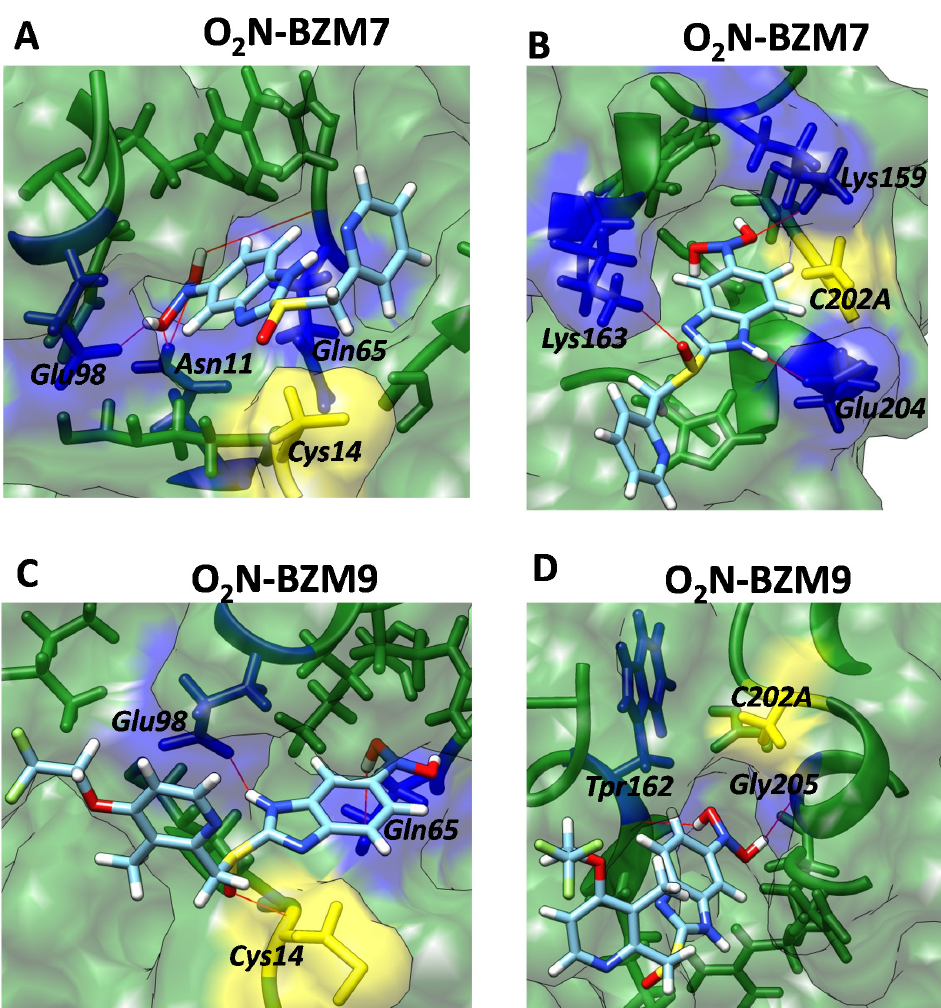
Figure 10. Prediction of docking between TPI protein (PDB entry 4BI7) and O 2 N-BZM7 and O 2 N-BZM9 : 3D representations of the binding model of O 2 N-BZM7 in the vicinity of ( A ) Cys14 and ( B ) C202A, and of O 2 N-BZM9 in the vicinity of ( C ) Cys14 and ( D ) C202A of TPI from G. lamblia . The interactions are shown in red, and Cys14 and C202A are shown in yellow.